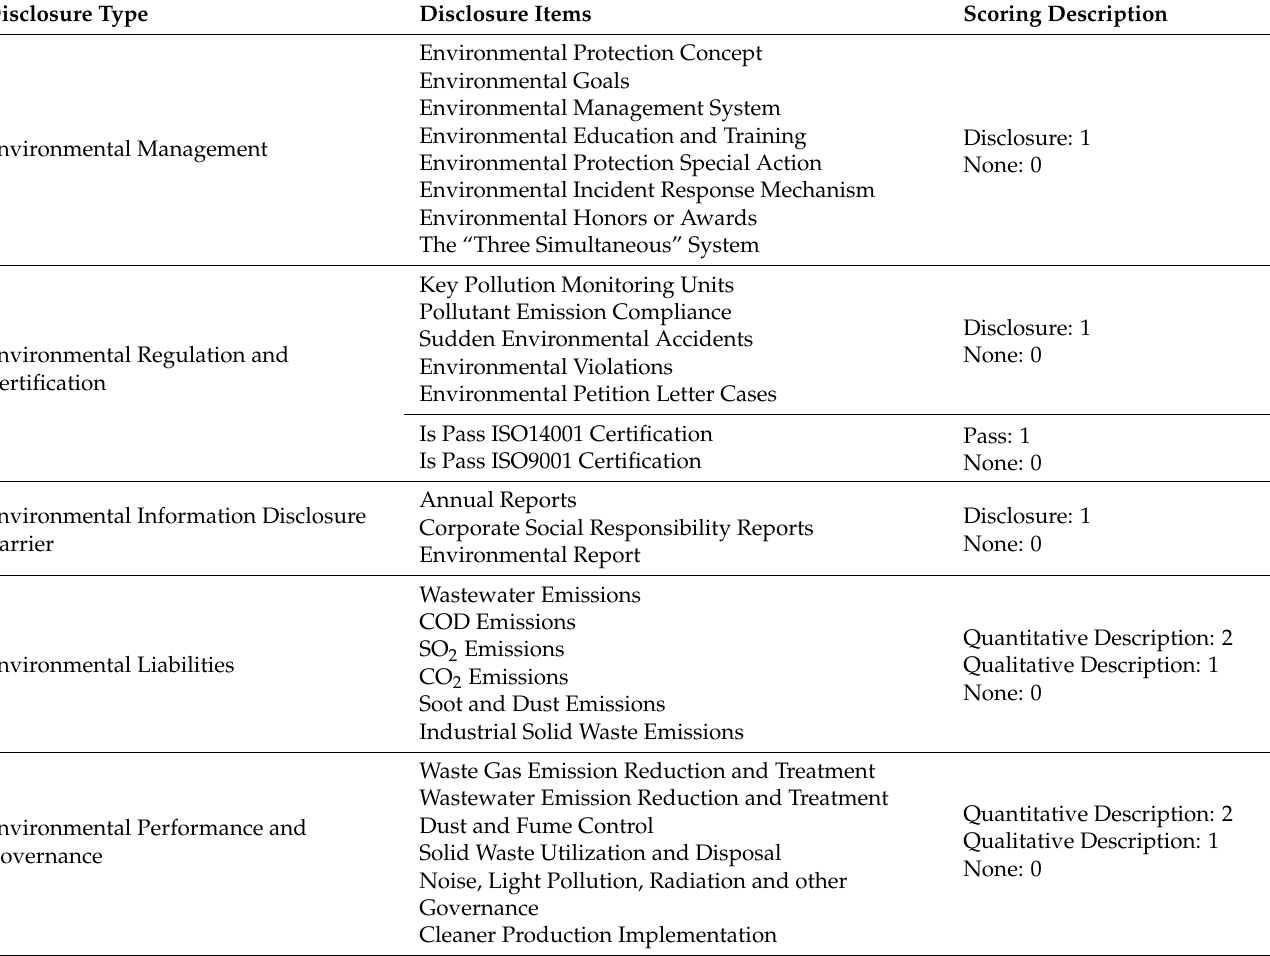
Table A1. Listed companies’ environmental information disclosure